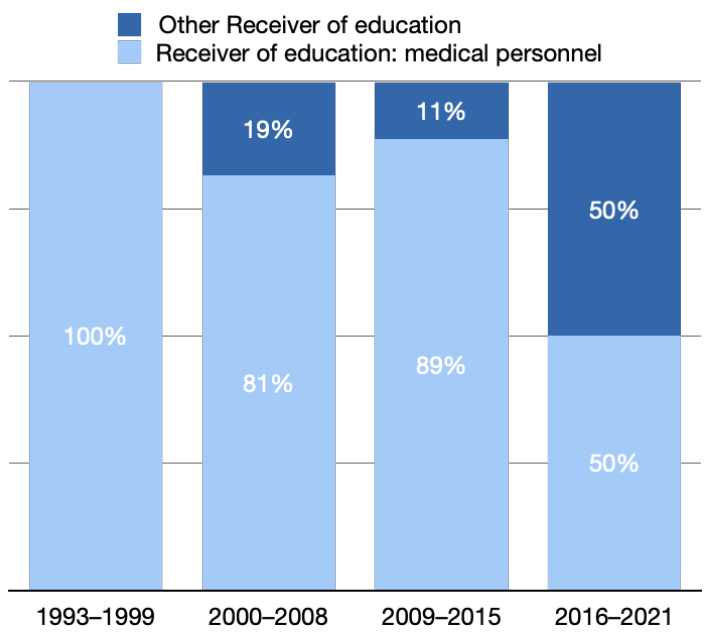
Figure 7. Distribution of receivers of education in different programs.